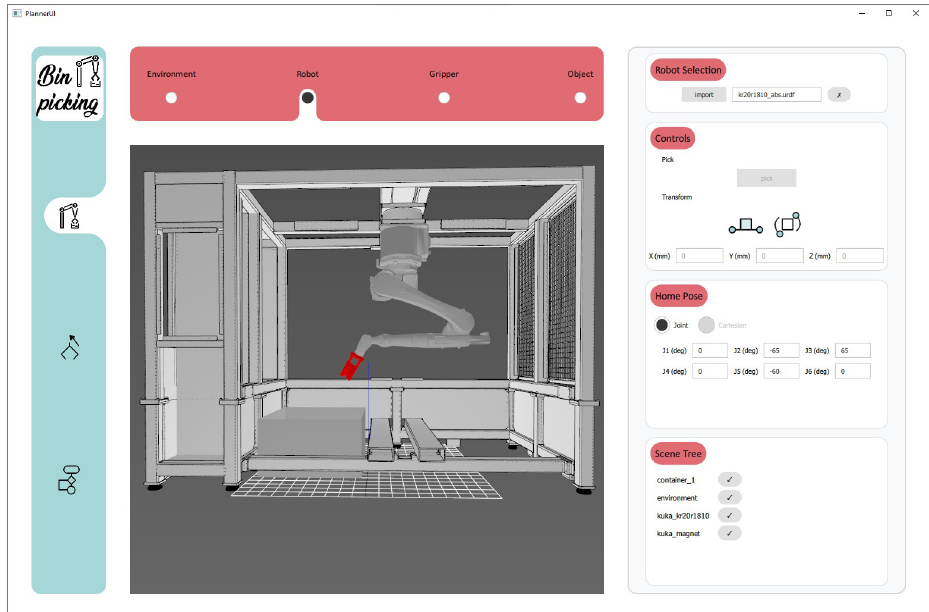
Figure 4. User interface of the pipeline definition application.